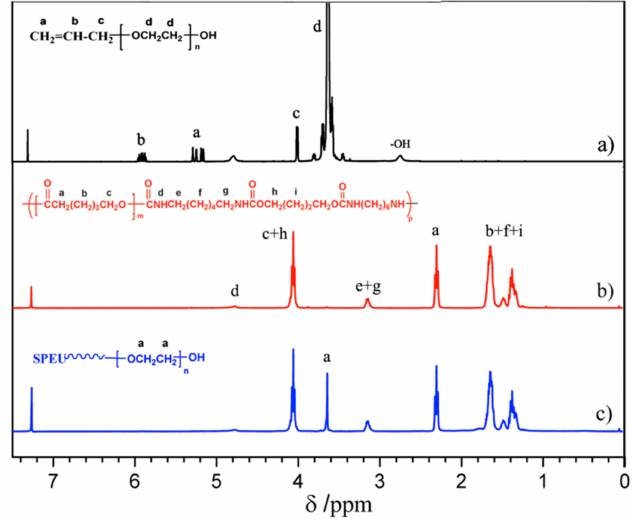
Figure 3. 1 H NMR spectra of ( a ) APEG; ( b ) SPEU; and ( c )